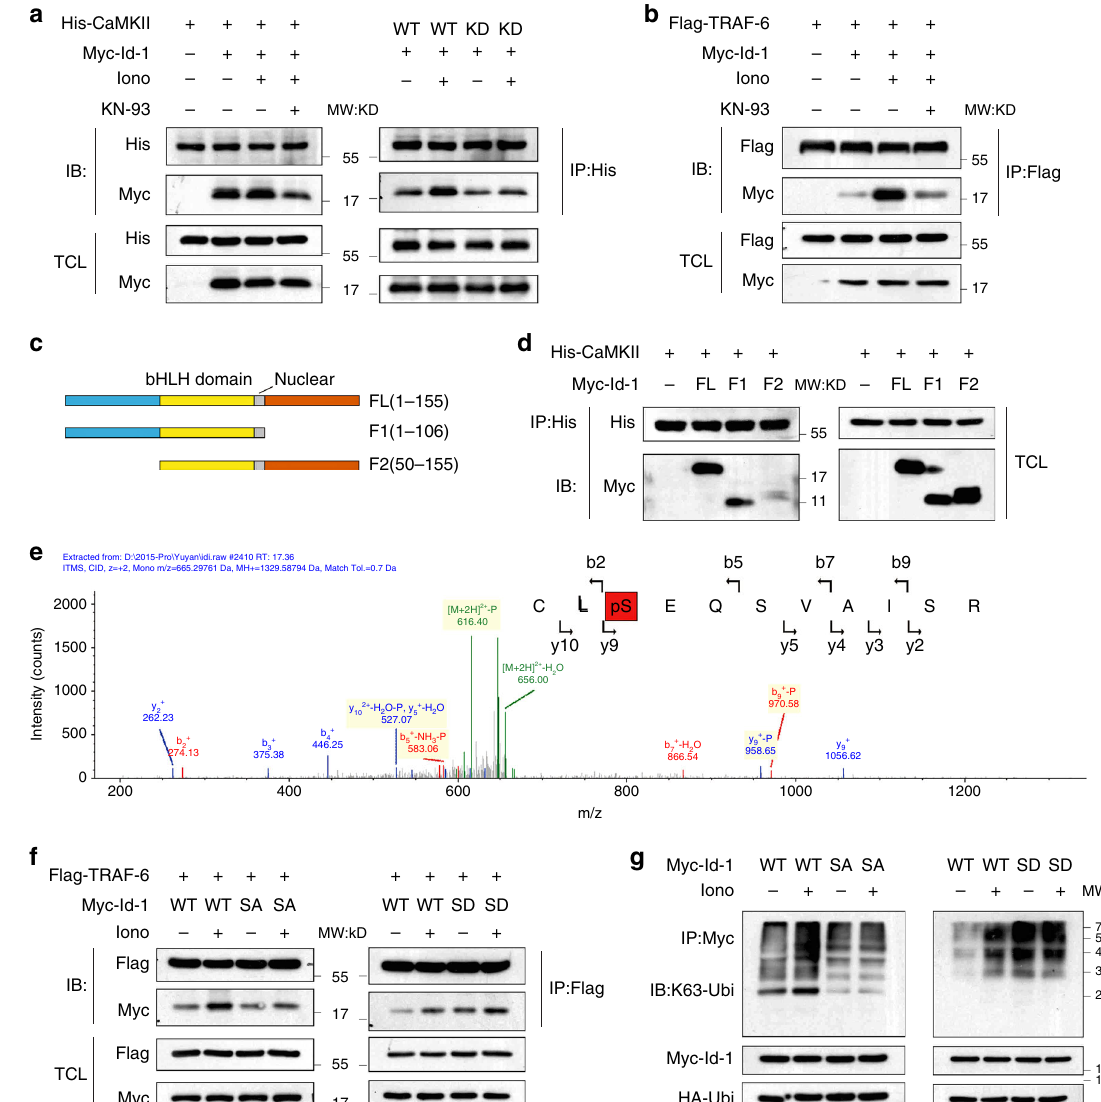
Fig. 7 The phosphorylation of Ser36 is essential to the Lys-63-linked ubiquitylation of Id-1. a The interaction between Id-1 and CaMKII. HEK293T cells were transfected with the indicated plasmids for 24 h, incubated with 6 μ M ionomycin or 10 μ M KN-93 for 24 h. His-tagged proteins were precipitated and analyzed by western blot using the indicated antibodies. b The interaction between Id-1 and TRAF-6. HEK293T cells were transfected with the indicated plasmids for 24 h, and then treated with 6 μ M ionomycin or 10 μ M KN-93. The cells were treated with Baf A1 for 4 h before collect. The whole-cell lysates were analyzed by immunoblotting after precipitated by a Flag-M2 beads. c The illustration of Id-1 deletion constructs. d The 1 – 50 AAs fragment of Id-1 was essential to binding with CaMKII. HEK293 cells were co-transfected with vectors encoding CaMKII together with Myc-Id-1 FL (full-length) or its deletion mutants. Protein extracts were immunoprecipitated using anti-His antibody. e Tandem mass spectrometry analysis of Id-1 proteins after incubation with recombinant CaMKII in a kinase reaction. The data shown that the serine residue corresponding to Ser36 (indicated in red background in the peptide sequence) is phosphorylated. y, product ion numbered from C terminus of the peptide; b, product ion numbered from N terminus of the peptide. f The phosphorylation of Id-1 Ser36 was essential for the interaction of Id-1 and TRAF-6. HEK293T cells were transiently transfected with the indicated plasmids for 24 h and then treated with 6 μ M ionomycin for 24 h and Baf A1 for 4 h before collect. The whole-cell extracts were subjected to western blotting using the indicated antibodies after an immunoprecipitation. g The phosphorylation of Id-1 Ser36 was required for the K63-ubiquitination of Id-1. HEK293T cells were transiently transfected with the indicated plasmids for 24h and then treated with 6 μ M ionomycin for 24 h and Baf A1 for 4 h before collect. The whole-cell extracts were subjected to western blotting using the indicated antibodies after an